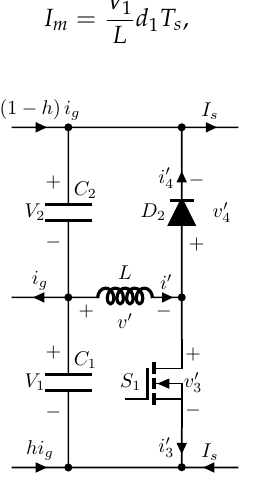
Figure 4. Equalizer circuit for the case V 1 > V 2 .